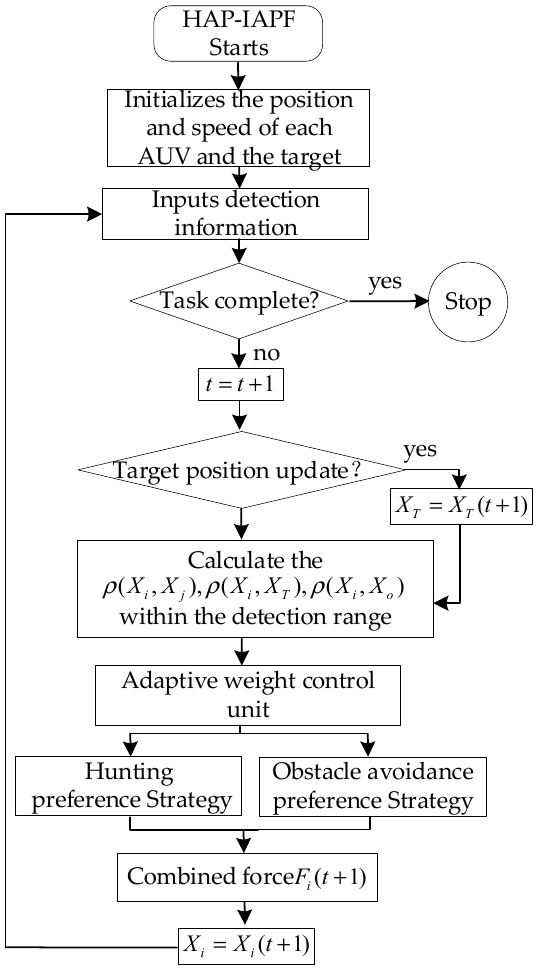
Figure 3. Flow chart of HAP-IAPF method.